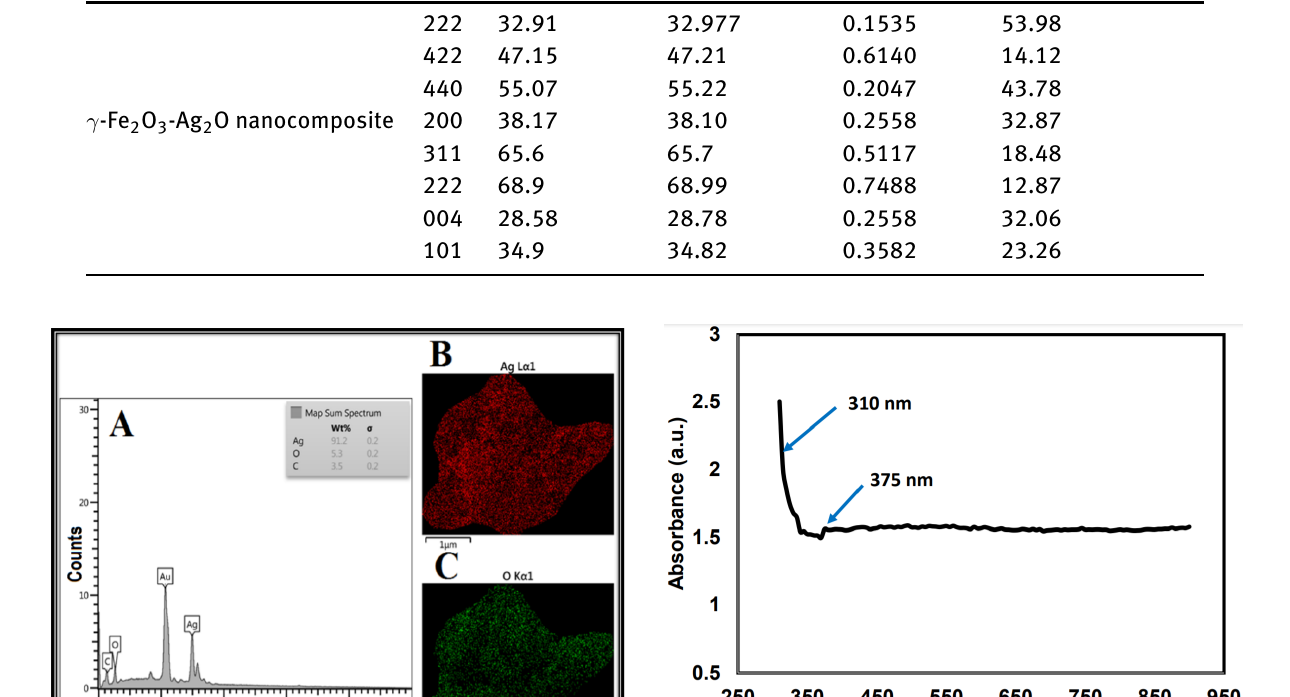
Table 1: XRD parameters of 𝛾 -Fe 2 O 3 -Ag 2 O nanocomposite. Material (hkl) 2 θ Exp. (deg.) 2 θ ICDD (deg.) FWHM (deg.)